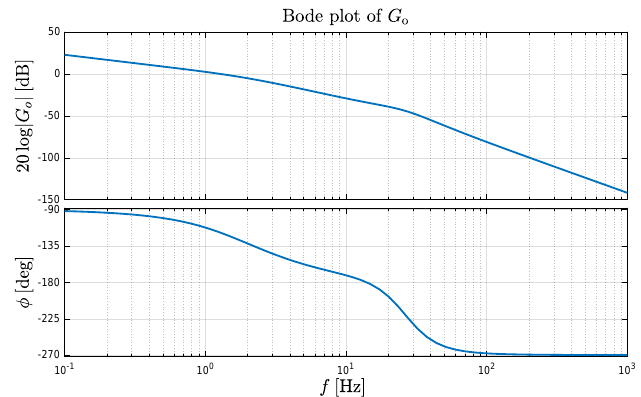
Figure 16. Bode plot of open-loop gain function.